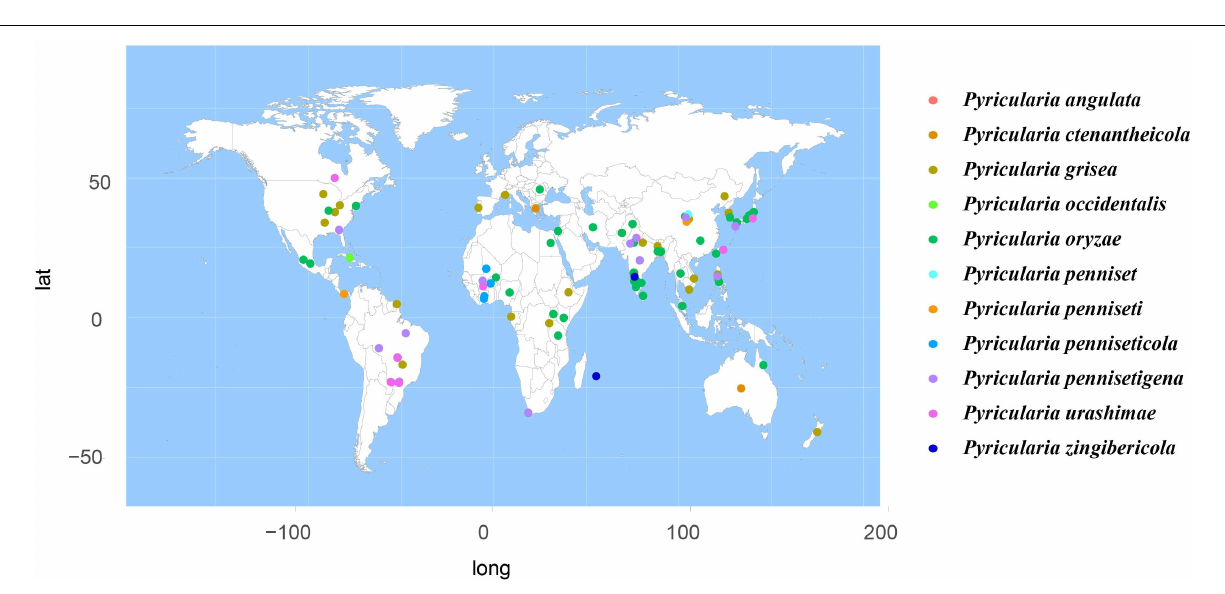
FIGURE 9 | Geographical distribution of Pyricularia using